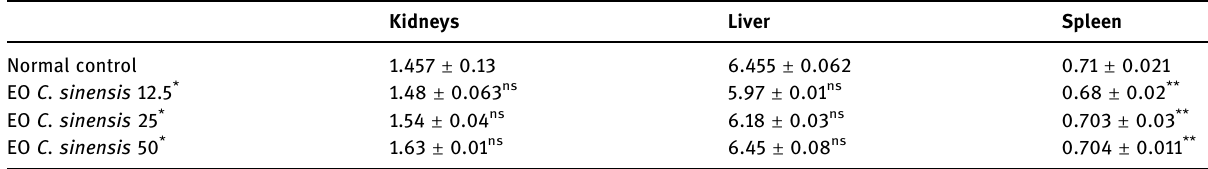
Table 4: Relative organ weight of the treated mice in the acute toxicity assessment